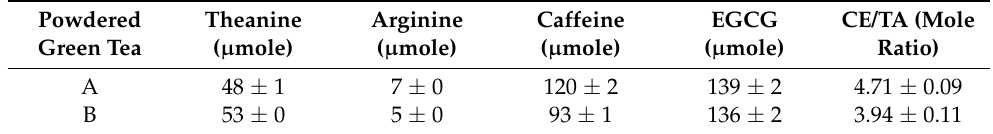
Table 5. Powdered green tea components used in the clinical trial.